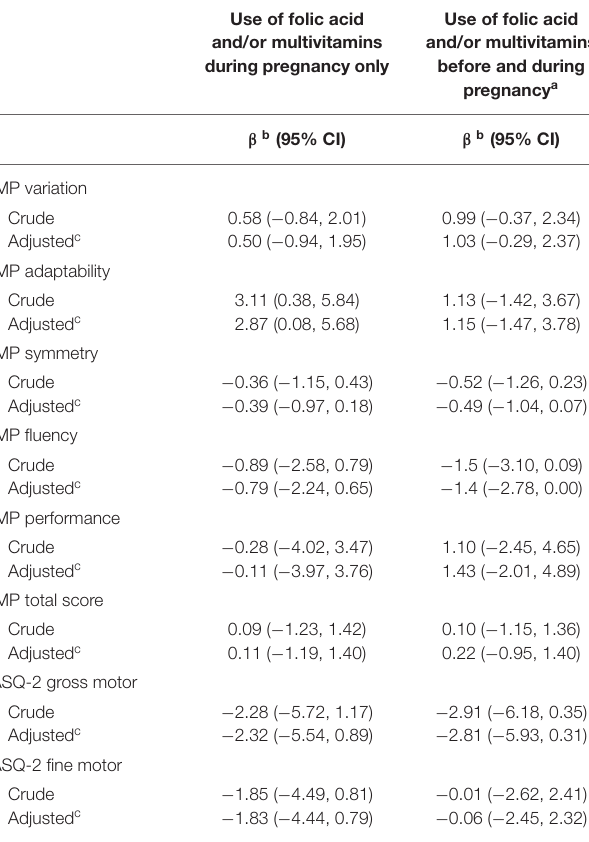
Use of folic acid and/or multivitamins before and during pregnancy a